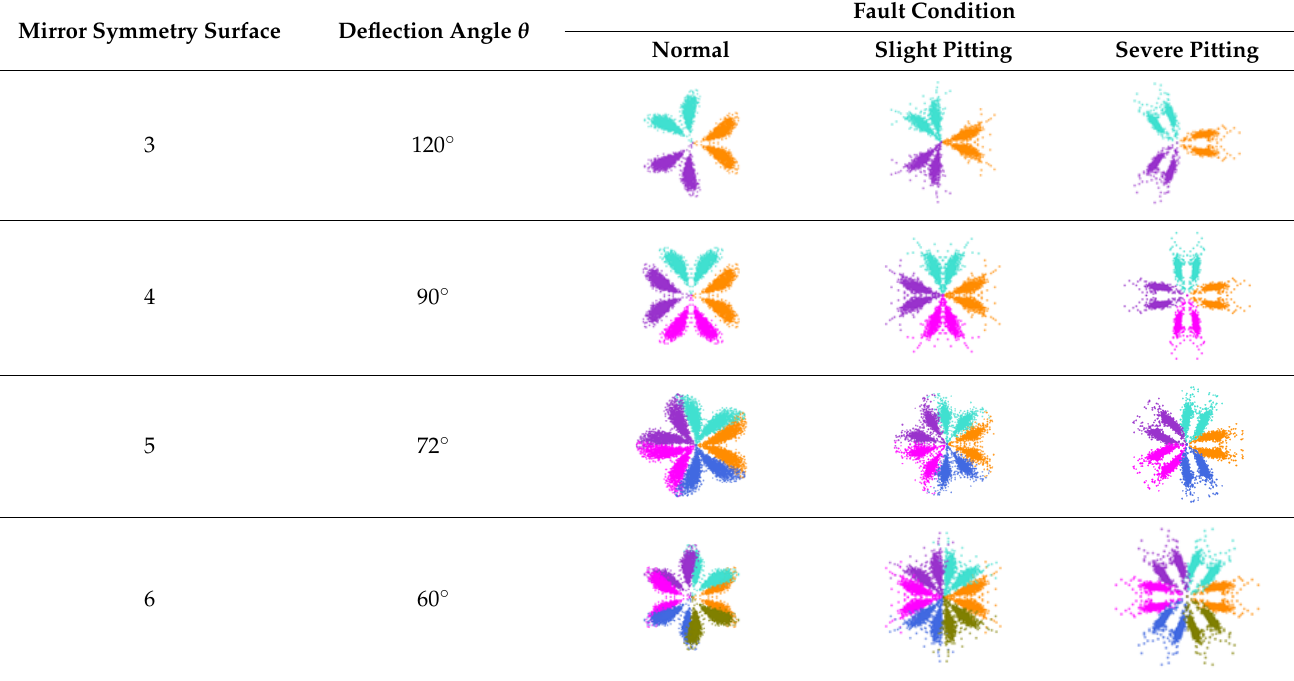
  at different bearing states. Table 3. SDP graphs for different values of deflection angle  at different bearing states. Table 3. SDP graphs for different values of deflection angle  at different bearing states. Table 3. SDP graphs for different values of deflection angle  at different bearing states. Table 3. SDP graphs for different values of deflection angle  at different bearing states. Table 3. SDP graphs for different values of deflection angle  at different bearing states. Table 3. SDP graphs for different values of deflection angle  at different bearing states. Table 3. SDP graphs for different values of deflection angle  at different bearing states. at different bearing states. Table 3. SDP graphs for different values of deflection angle    at different bearing at different bearing states. Table 3. SDP graphs for different values of deflection angle at different bearing states. Table 3. SDP graphs for different values of deflection angle Fault Condition